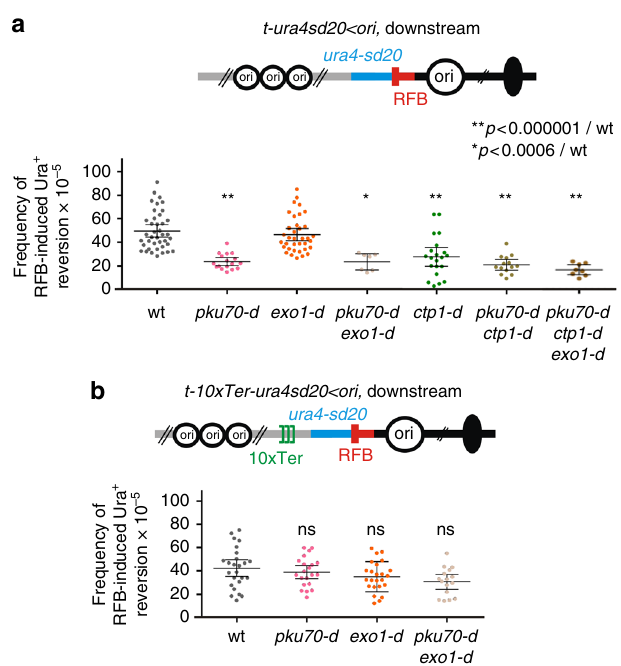
Fig. 6 The lack of Ku slows down HR-mediated fork-restart. a Frequency of downstream RFB-induced Ura + reversion, as described on Fig. 1c. b Frequency of downstream RFB-induced Ura + reversion using the t-10xTer- ura4sd20 < ori construct at which the progression of the converging fork is delayed. Each dot represents one sample from independent biological replicates. Bars indicate mean values ± 95% CI. Statistics were calculated using the Mann-Whitney U test. See Supplementary Fig. 4 for the expression of recombination factors and analysis of the lig4-d